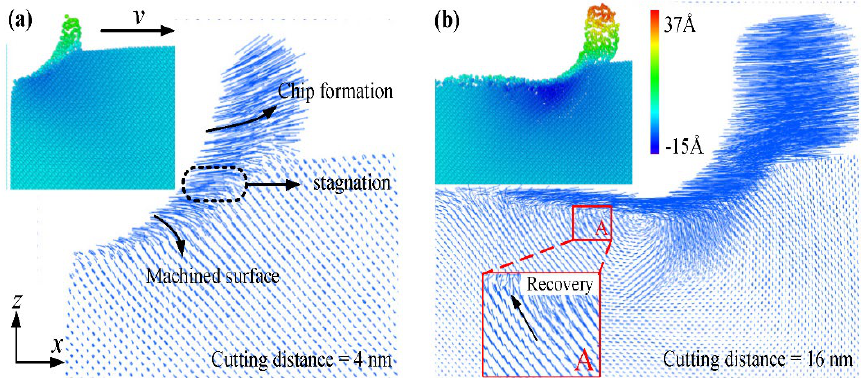
Figure 41. The displacement vectors of the workpiece atoms during nanometric cutting at a distance of ( a ) 4 nm and ( b ) 16 nm [201].